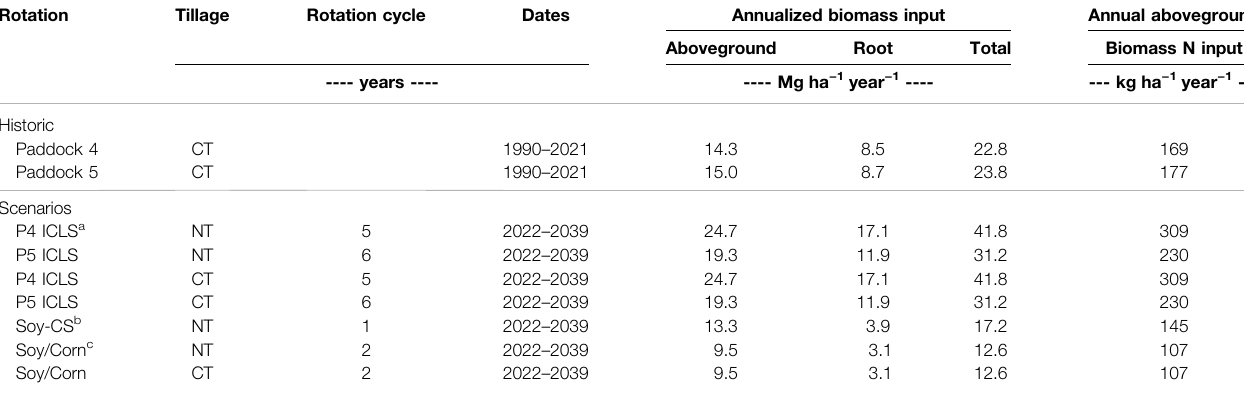
TABLE 5 | Annualized biomass inputs for Paddock 4 (P4), Paddock 5 (P5) and future rotation scenarios. Rotation